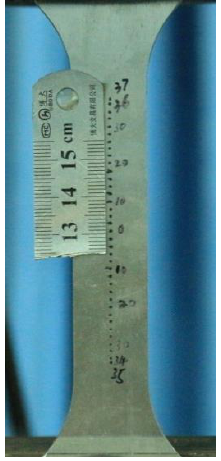
Figure 3. Marked specimen. Figure 3. Marked